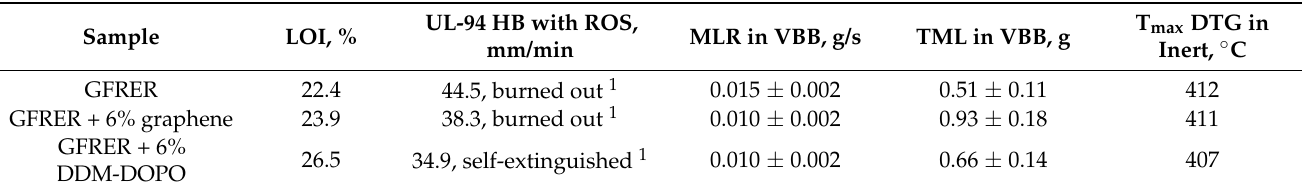
Table 1. The LOI, UL-94, and TGA data, the mean mass loss rate (MLR), and the total mass loss (TML) in the VBB